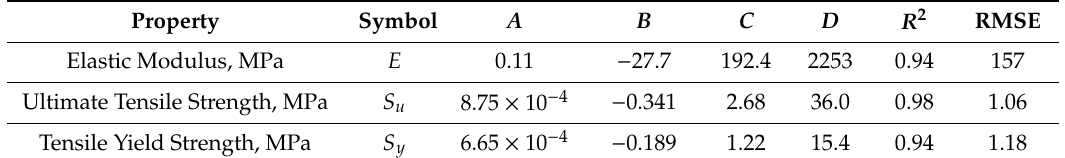
Table 1. Constants of empirical relationships for HDPE tensile properties. Property